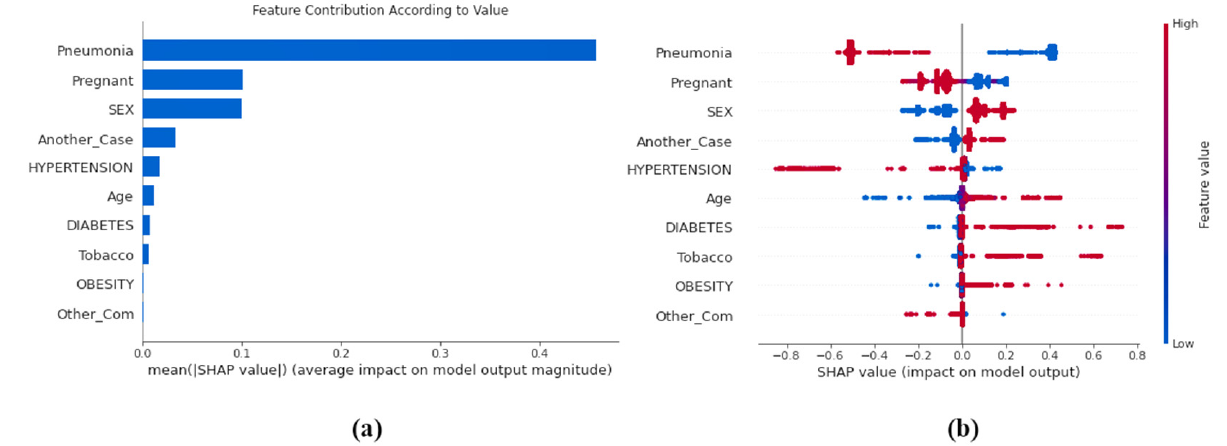
Figure 10. ( a ) Bar chart using SHAP ( b ) beeswarm plot indicating Shapley values. LIME: The LIME feature importance models are described in Figure 11. Figure 11a de- scribes a COVID-19 positive patient and Figure 11b describes a COVID-19 negative